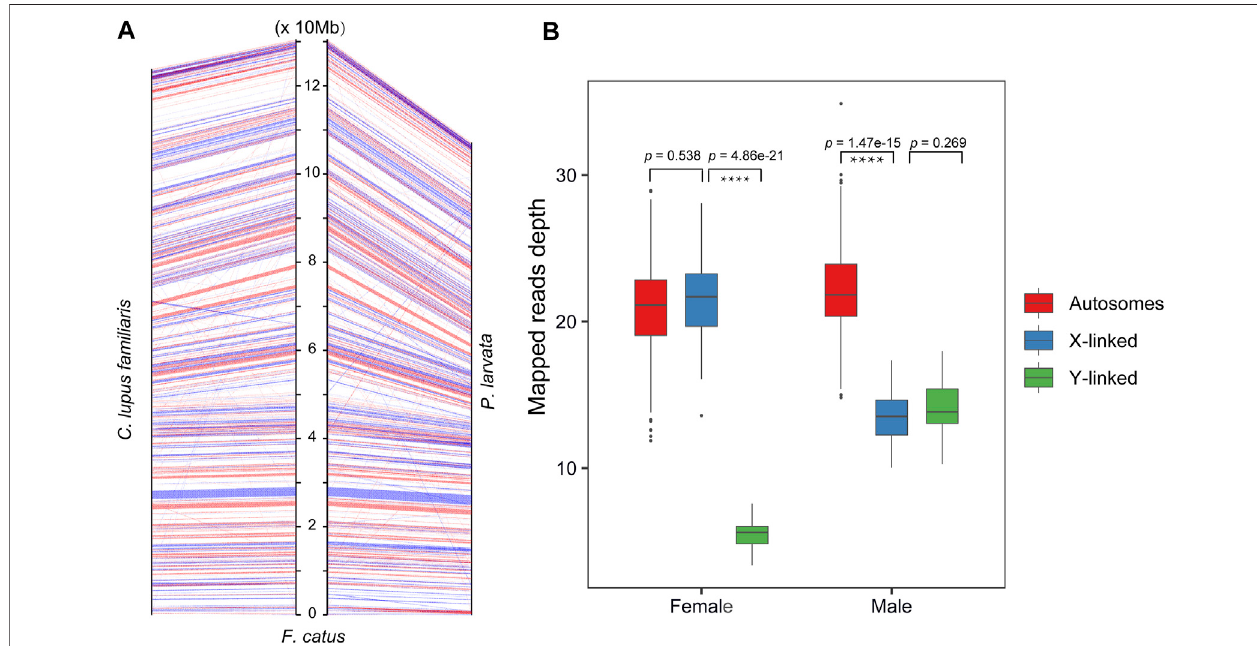
FIGURE 2 | The identi fi cation of sex-linked regions in this study. (A) Anchoring genes on the X chromosome ofthe F. catus to the P. larvata and C. lupus familiaris . (B) The read depth mapped to autosomes, X-linked region, and Y-linked region of the 45 re-sequenced P. larvata individuals.